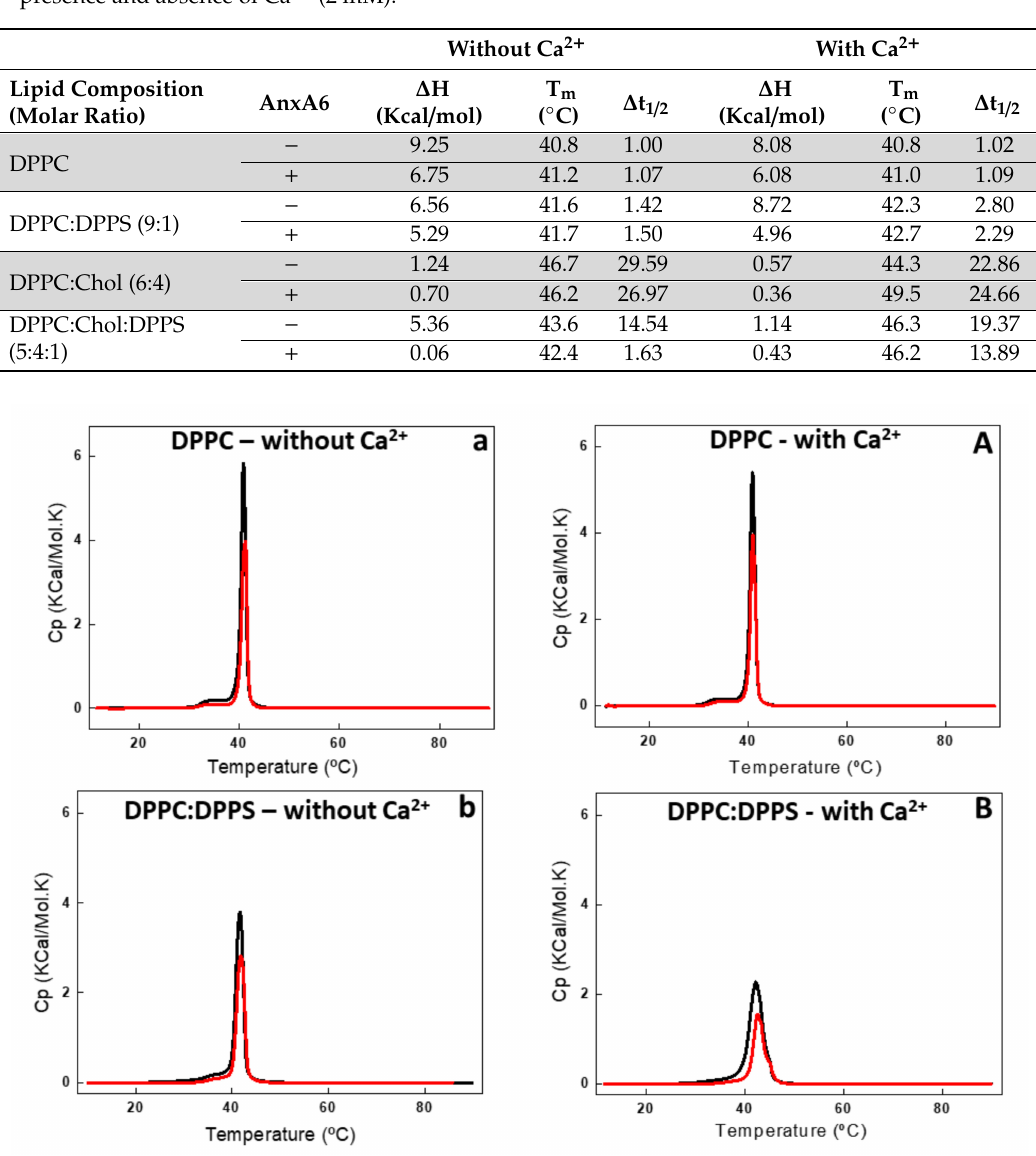
Figure 3. Di ff erential scanning calorimetry (DSC) thermograms of DPPC ( a , A ) and 9:1 DPPC:DPPS ( b , B ) liposomes (10 mg / mL, total lipid concentration) in the absence (lower case letter) and in the presence (capital letter) of 2 mM Ca 2 + . DSC thermograms were processed in excess heat capacity (C p ) (kcal / K.mol) as function of temperature ( ◦ C) of liposomes (black line) and proteoliposome (red line) harboring